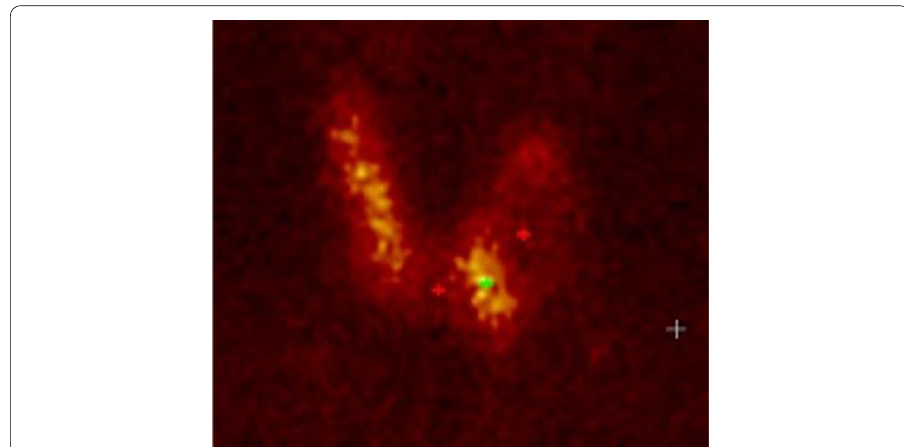
Fig. 1. 99m Tc planar thyroid scan showing a cold left thyroid nodule